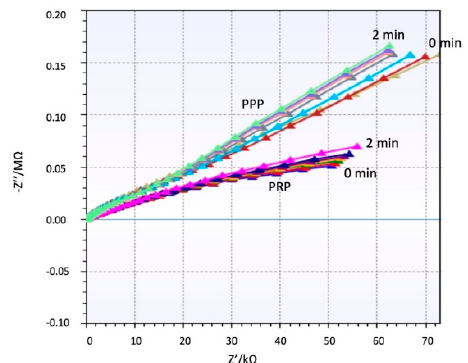
Figure 4. Real and Imaginary part of Impedance for plasma poor in platelets (PPP) and plasma rich in platelets (PRP) over time.